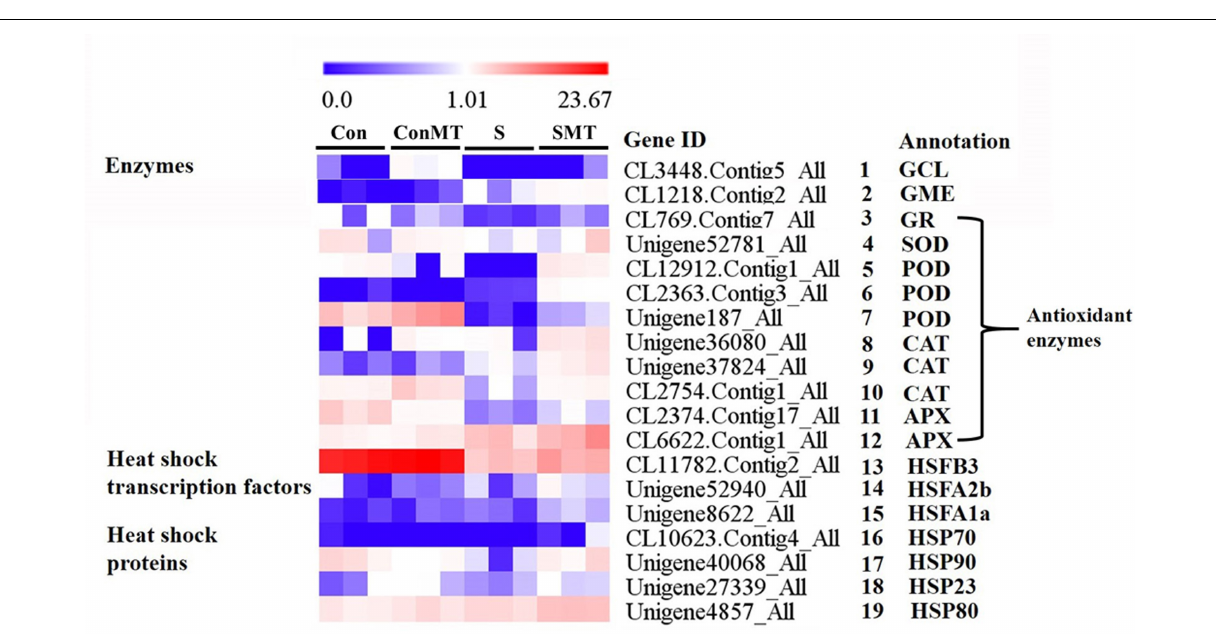
and PP2C56) ( Figure 7 , #3 to #14), the ABA-insensitive ( ABI5 ) #28), and two small auxin-up RNA (SAUR) ( Figure 7 , #25 to #26), were detected in ConMT/Con as induced and related